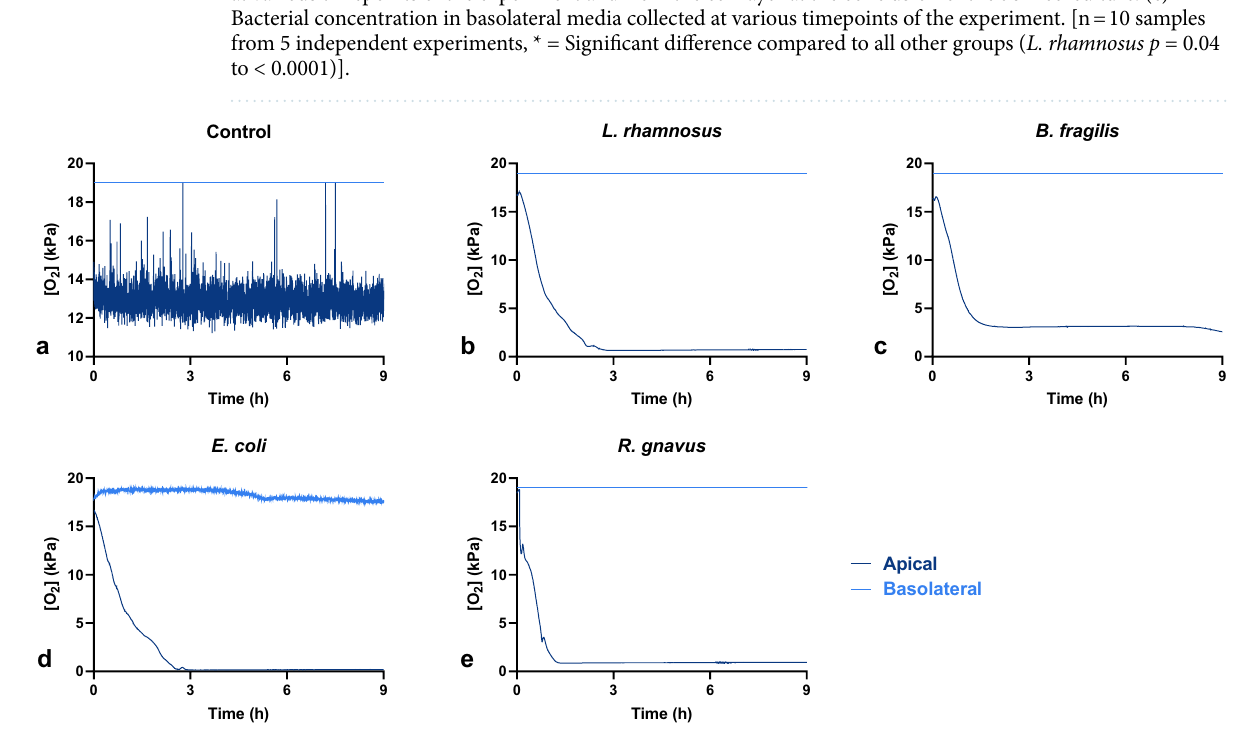
Figure 3. Co-culturing an intestinal mucosa model with live microbes results in a decline in measured oxygen levels compared to control. Representative traces of oxygen tension in the apical and basolateral compartments over the course of a 9-h overnight period for each co-culture. Measurements repeated a total of three times over three independent